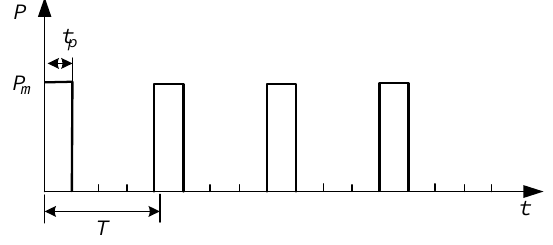
Figure 17. Power consumption of conditional transmission of a node.